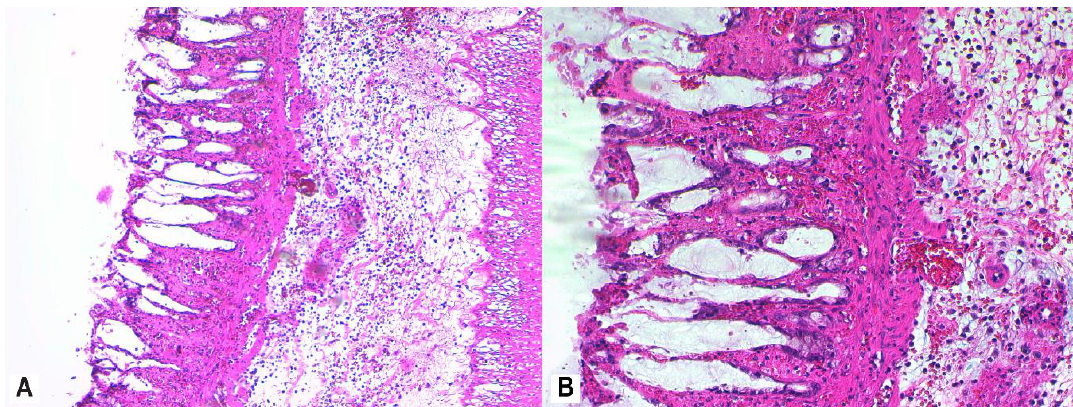
Figure 9. Colon histology of rats administered both MSB and MM (AA + MSB + MM group). Colon tissue of rats that were administered MSB and MM for 11 consecutive days prior to AA exposure was collected 24 h after AA exposure and demonstrated moderate inflammatory infiltrate in the mucosa and submucosa, absence of neutrophils in the lamina propria, neutrophil infiltration of crypt epithelium in <5% of crypts, recovering luminal epithelium, and increased crypt density and restoration of intestinal crypt architecture; H&E stain, 10× ( A ), 20× ( B ). Abbreviations: AA, acetic acid; H&E, hematoxylin and eosin; MSB, MegaSporeBiotic ™ ; MM, MegaMucosa ™